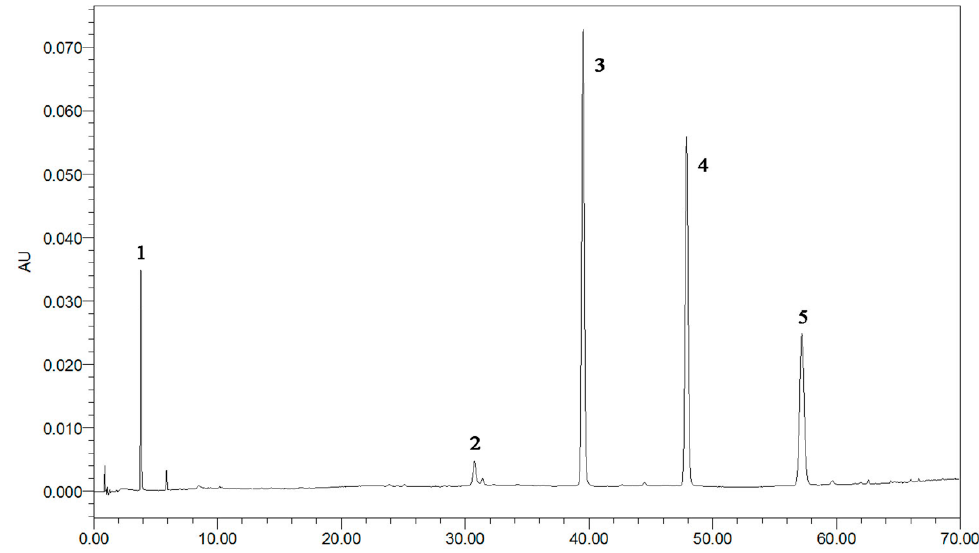
Figure 2. The typical UPLC chromatographic profile of five standards peaks: 1 : GA (3.8 3min); 2 : EA (30.7 min); 3 : kaempferol-3- O -sophoroside (38.9 min); 4 : hyperoside (48.9 min); 5 : astragalin (57.2 min).